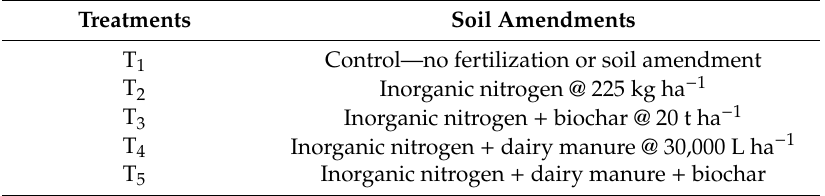
Table 1. Experimental treatments including di ff erent nutrient management practices to produce silage-corn in Newfoundland, Canada.